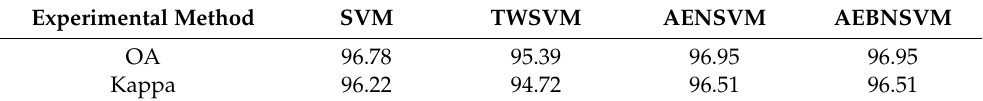
Figure 12. Classification results of different categories of Kennedy Space Center hyperspectral images. Table 8. Classification results of Kennedy Space Center hyperspectral